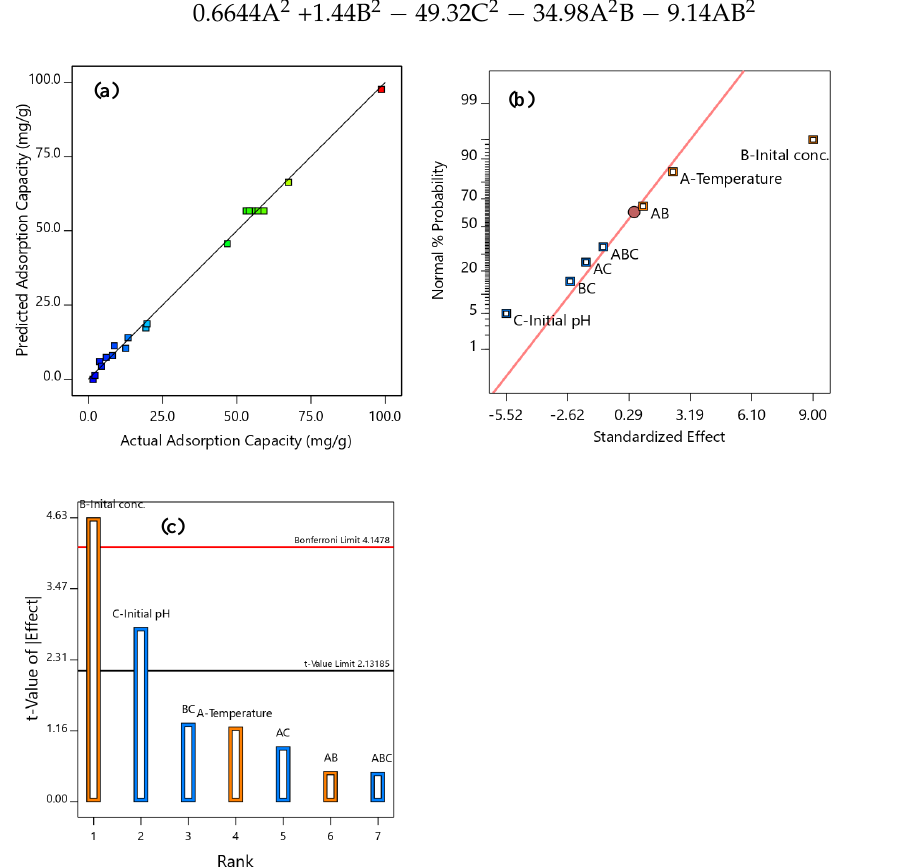
Figure 3. SBAC-MgAlFe-LDH adsorption capacity model’s ( a ) Experimental (actual) versus predicted values, ( b ) Probability normal plot, ( c ) Pareto chart.